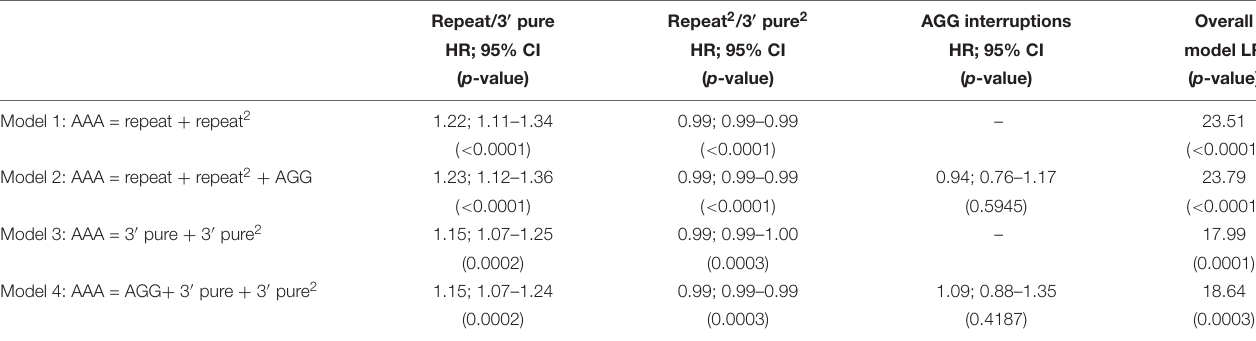
TABLE 3 | Survival analysis models based on all women with a premutation ( N =